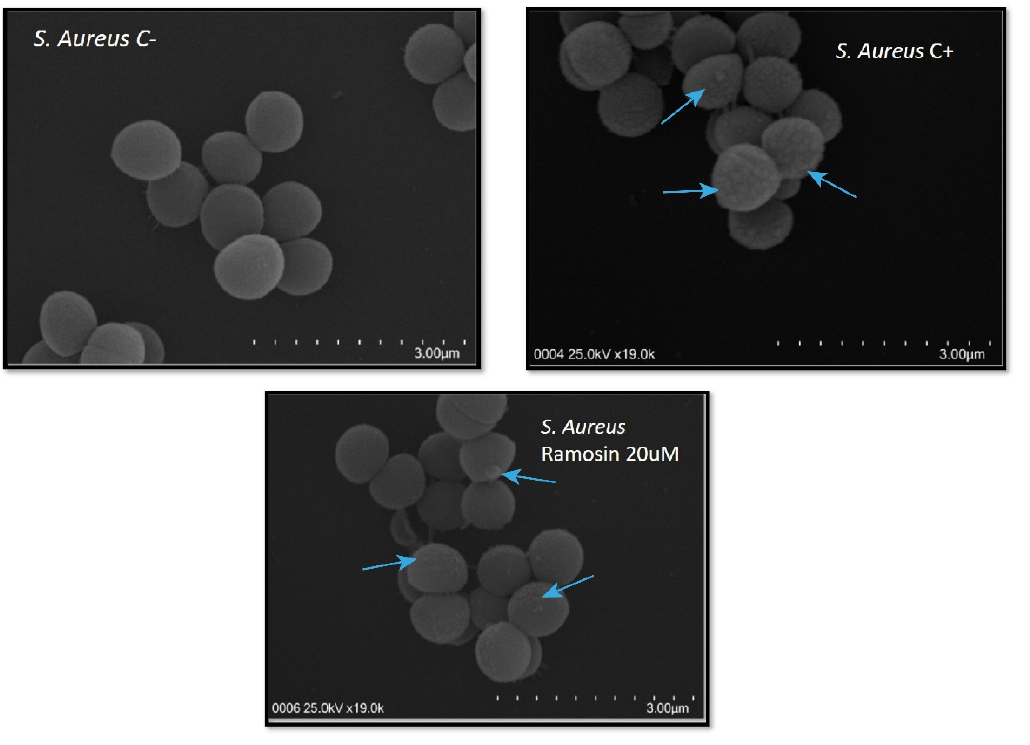
Figure 6. Scanning electron microscopy of the Gram-positive bacteria S. aureus. Bacteria were treated with Ramosin peptide at 20 μ M. C-: S. aureus without treatment. C+: BTM-P1 peptide at 20 μ M [47]. The blue arrows indicate the disturbances that occurred in the membrane of S. aureus .